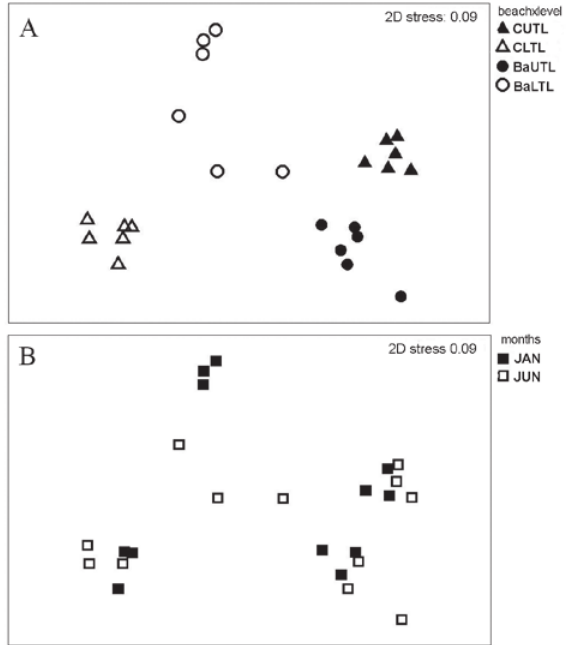
Fig. 5 - Nematode assemblages: output of non-metric Multi- Dimensional Scaling (MDS) based on non-transformed genus density. A: MDS of tidal levels and beaches; B: MDS for months. Abbreviations as showed in the previous figure.